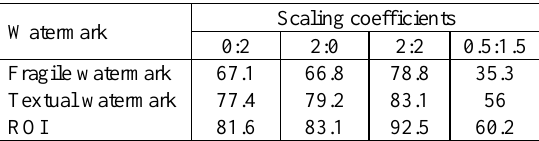
Table 2. BCR estimates under scaling attacks